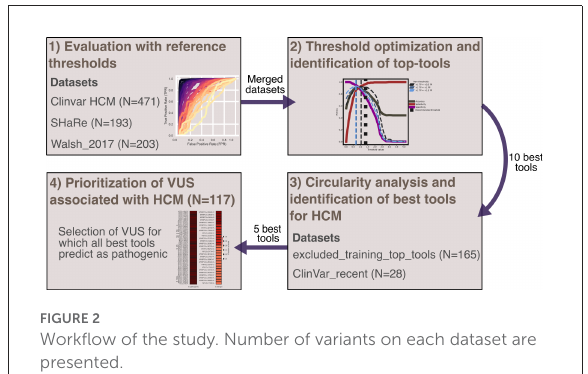
FIGURE2 Workflow of the study. Number of variants on each dataset are presented.